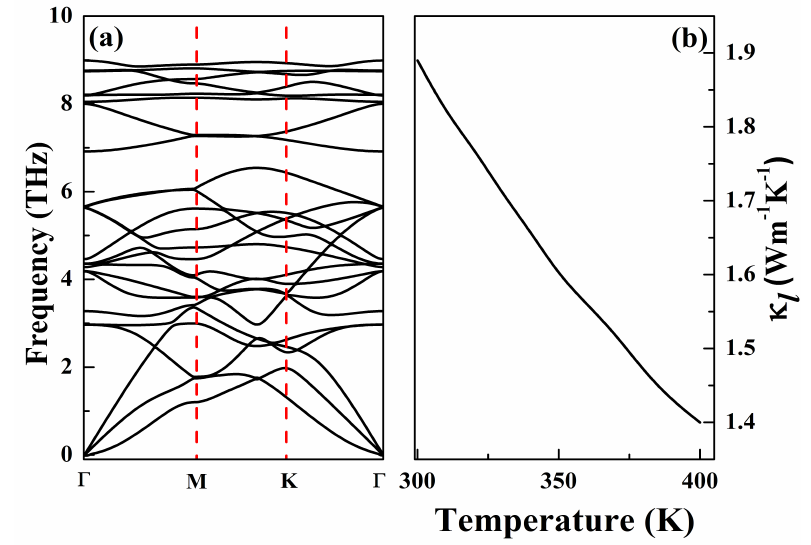
Figure 4. Phonon dispersion spectra (a) and lattice thermal conductivity (b) of NiCl 3 monolayer.